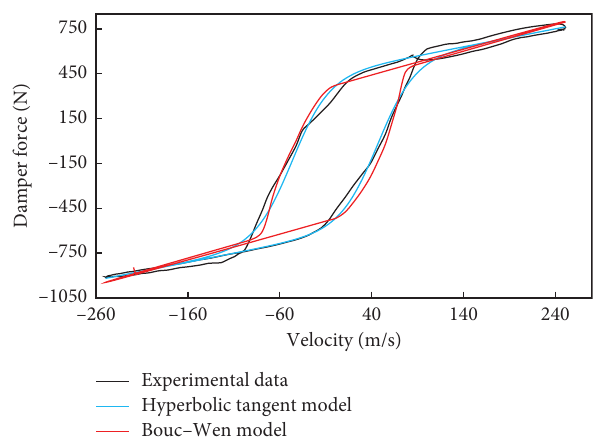
Figure 9: The calculation results of different